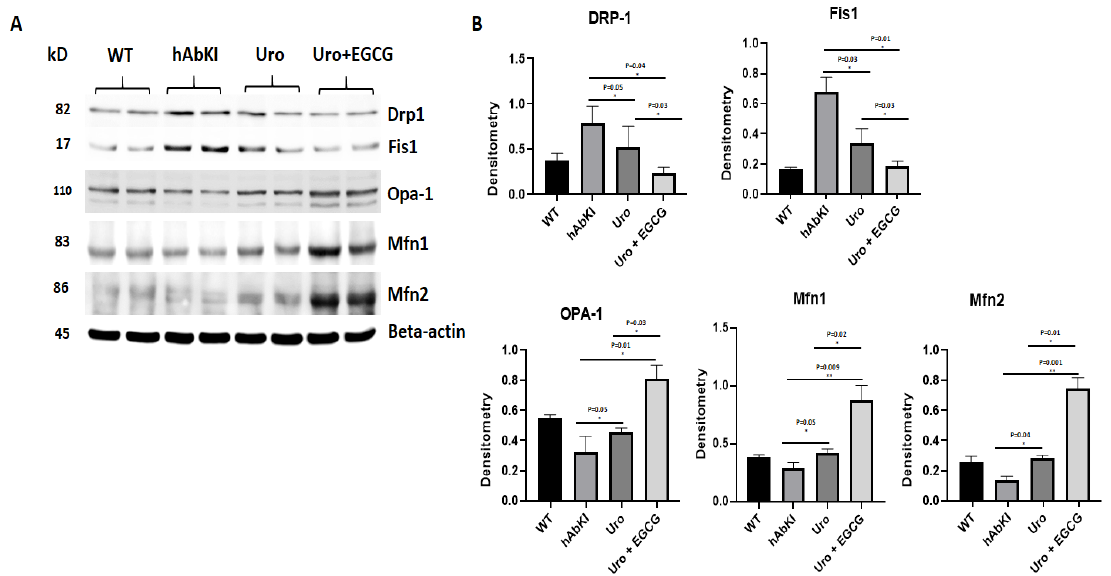
Figure 3. Immunoblotting analysis of mitochondrial dynamic proteins . Immunoblotting analysis